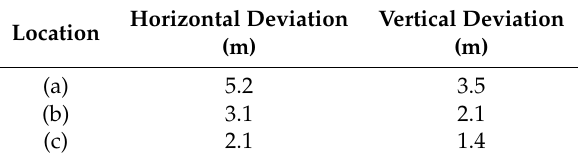
Table 4. Horizontal and vertical deviations at the three locations along the beam caused by the difference in azimuth and elevation angle between the measured and modeled